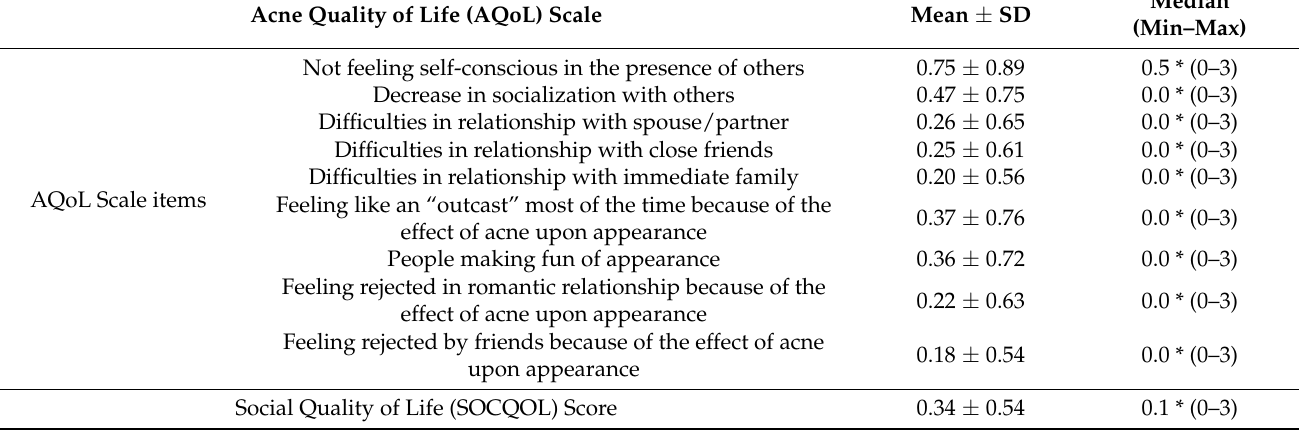
Table 2. The Acne Quality of Life (AQoL) Scale detailed results accompanied by the Social Quality of Life (SOCQOL) Score in the group of Polish female adolescents participating in the study.